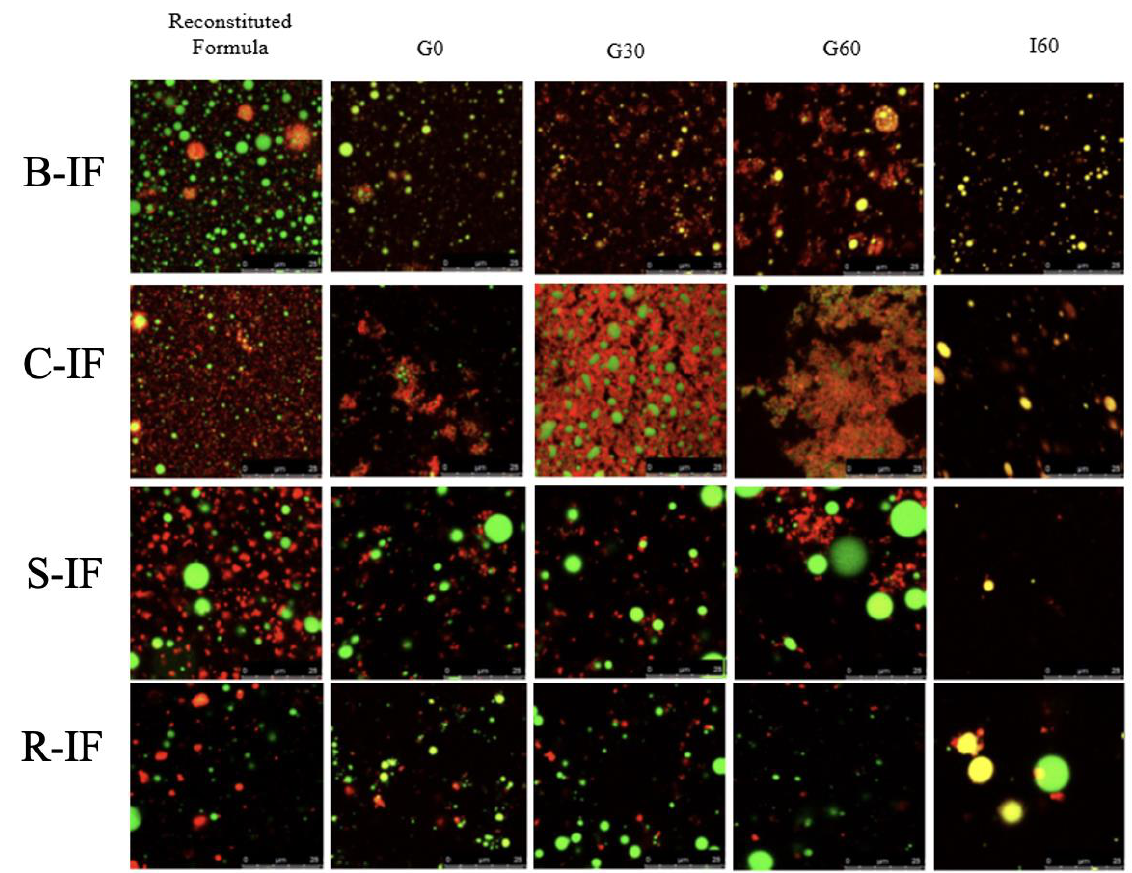
Figure 4. CLSM micrographs of infant milk formula (IF) samples at each digestion timepoint. B-IMF (bovine IF), C-IF (caprine IF), S-IF (soy IF), and R-IF (rice IF). Red colour represents protein, and green colour represents fat. Scale bars are 25 µm.